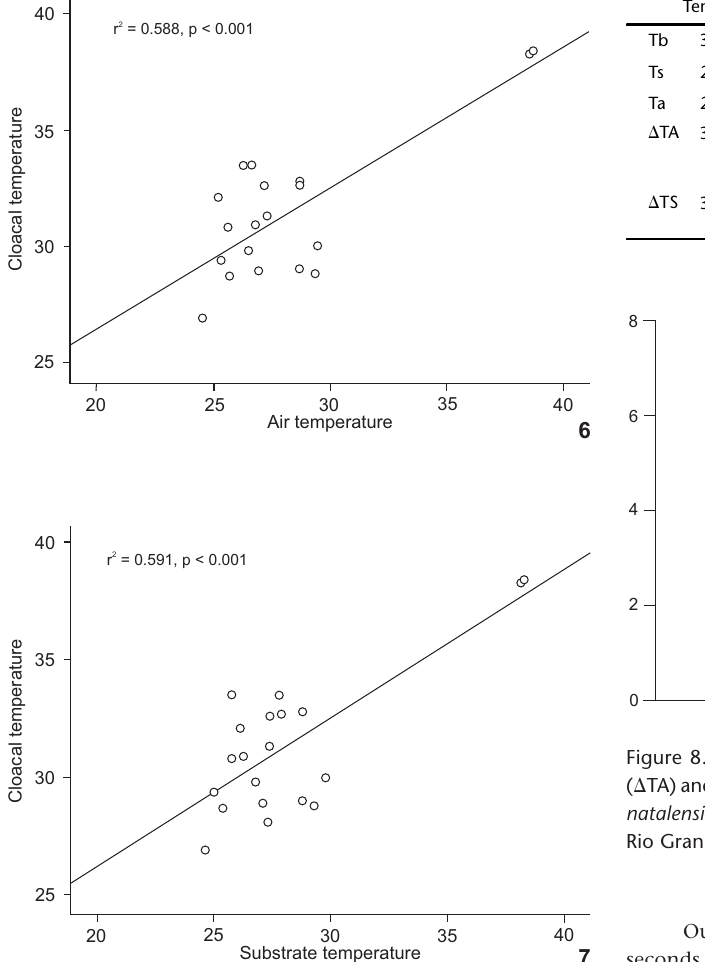
Figures 6-7. Relationships between body temperature of active Coleodactylus natalensis and environmental temperatures in the Parque Estadual Mata da Pipa, Tibau do Sul, Rio Grande do Norte,